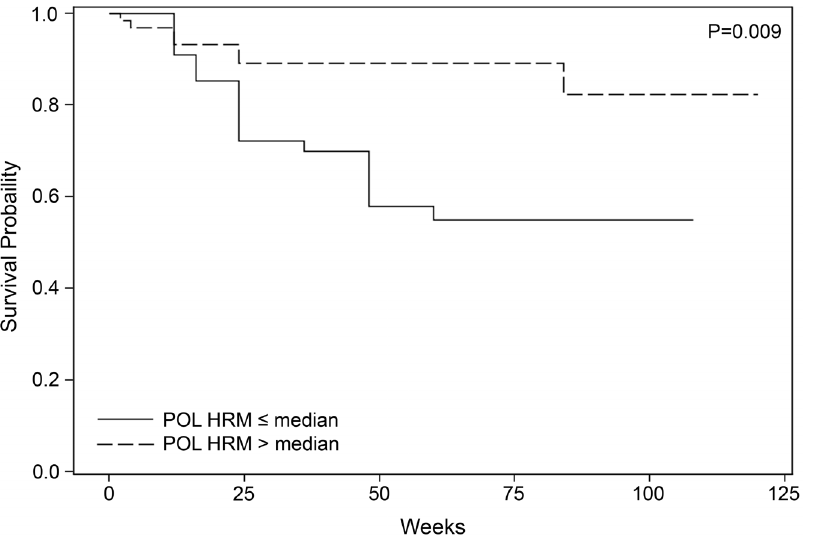
Figure 2. Association of POL HRM scores and time to virologic failure or death. The figure shows a Kaplan-Meier plot of time (weeks) to the composite endpoint of virologic failure or death for children with pre-treatment POL HRM scores above or at/below the median score of 4.3. The significance level is calculated from a Cox proportional hazards regression adjusted for study treatment, entry age, CD4%, and HIV viral load.